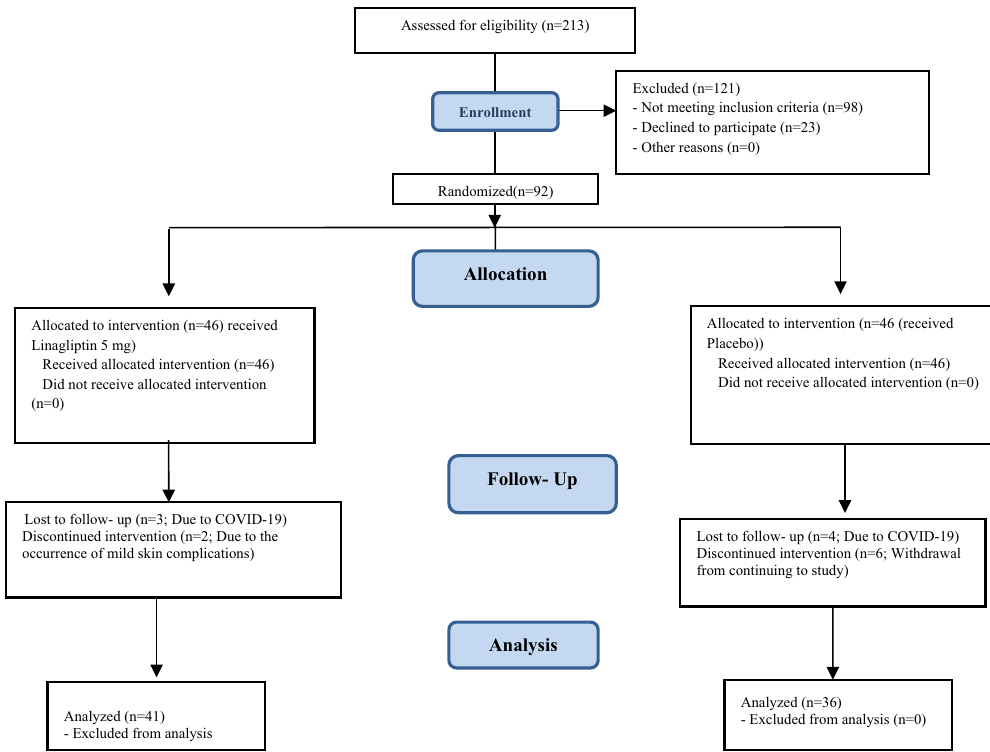
Figure 1. Consort flow diagram for recruitment of